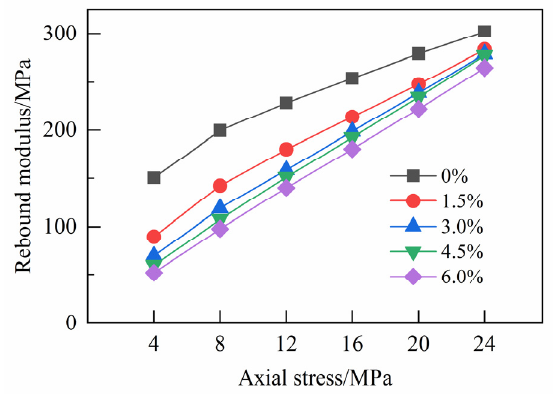
Figure 9. Relation curves of rebound modulus and stress.